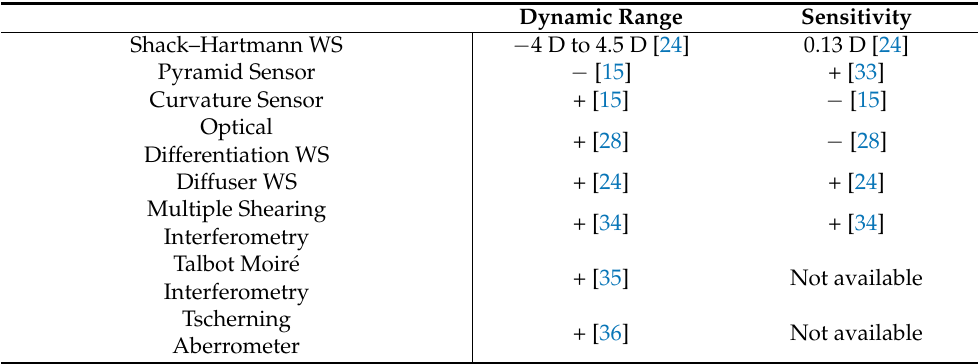
Table 2. Comparison between Shack–Hartmann WS and other wavefront sensors in terms of dynamic range and sensitivity. A plus sign + is used when better working ranges than those of the Shack– Hartmann WS have been reported in the literature for the sensor under consideration; in the opposite case, a minus sign − is used. For Shack–Hartmann WS, numerical working ranges are added as a reference from a study published by McKay et al. (Ref.